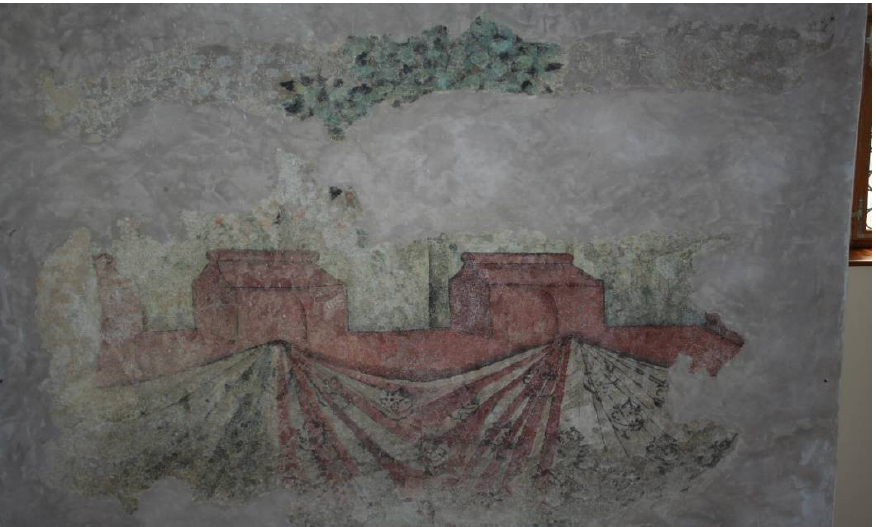
Figure 9. Loket, the first floor of the palace of Wenceslas IV, today called the Governor’s House, probably the end of the 14th century. Photo by František Záruba, the author’s own work.